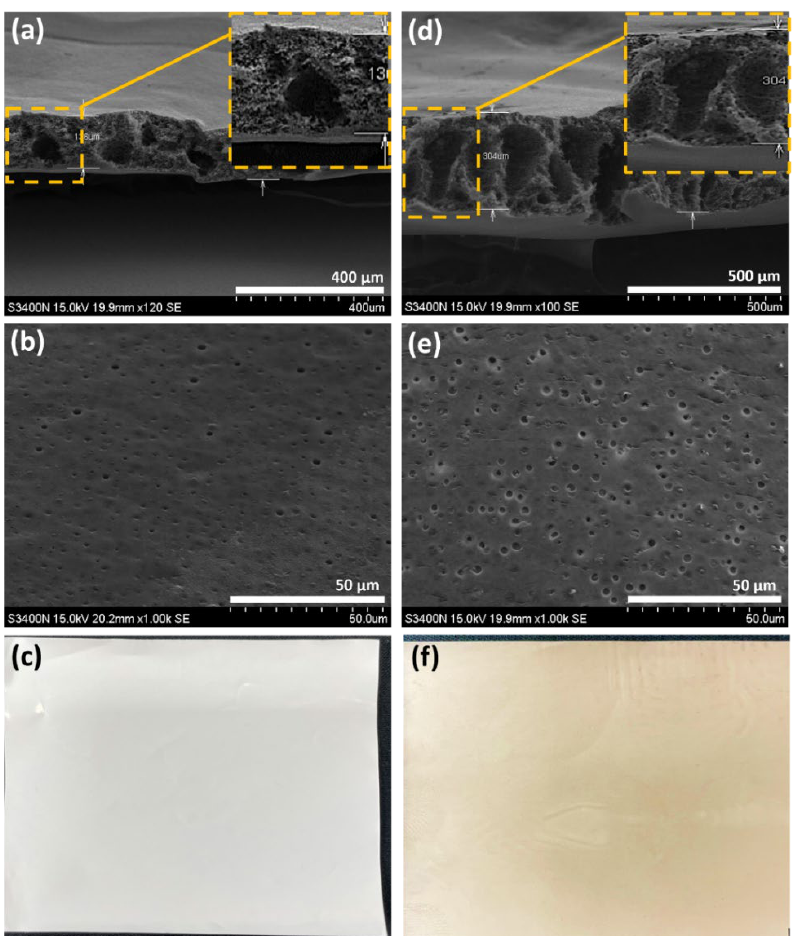
Figure 3. SEM images of ( a ) cross-section, ( b ) top view, ( c ) optical photo of 16 wt.% pristine PSF membrane; and ( d ) cross-section, ( e ) top view, ( f ) optical photo of 16 wt.% PSF/0.6 wt.% GO membrane.